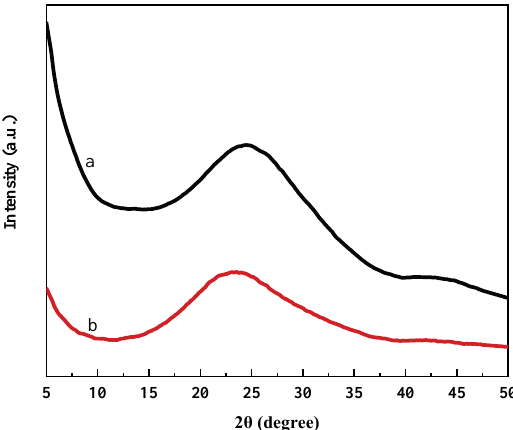
Figure 3. XRD patterns of RGO (a) and RGO-SiO 2 (b).